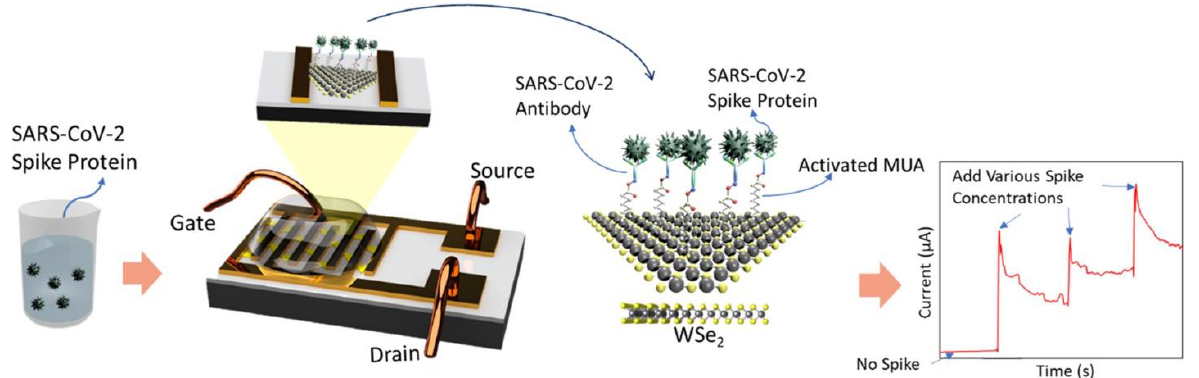
Figure 3. Graphical illustration of the fabrication and working of the monolayer WSe 2 -based FET COVID-19 sensor. The FETs were fabricated via photolithography. Monolayer WSe2 crystals were functionalized with COVID-19 antibodies (used as a base sensing platform) via 11-mercaptoundecanoic acid (MUA). The MUA was activated with an n-hydroxysuccinimide (NHS) and carbodiimide hydrochloride (EDC) solution. The detection of the SARS-CoV-2 spike protein was evaluated by the corresponding effects on the electrical transport properties. Reprinted with permission from [147].